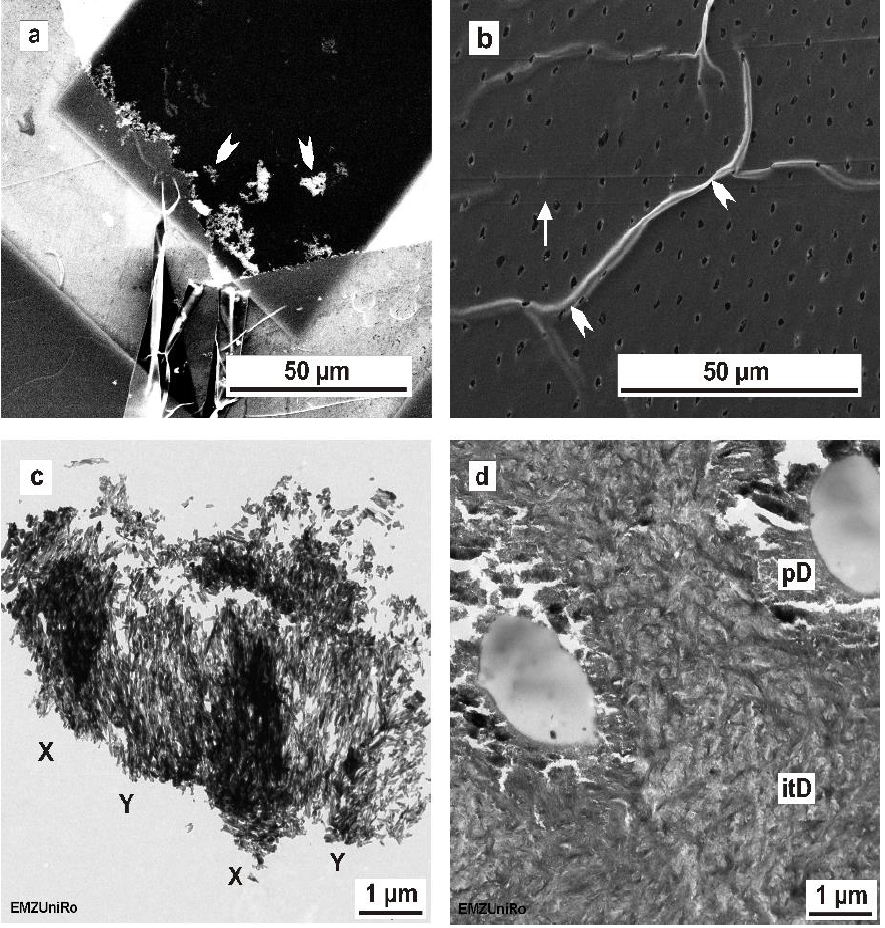
Figure 7. Dentine and enamel ultrathin sections showing ultramicrotome-induced artefacts. ( a ) SEM image of ultramicrotome-prepared enamel. TEM examination is only possible near the enamel – epoxy – resin interface (white arrow heads). Enamel in the center of the ultrathin section became lost during the preparation process using ultramicrotomy. ( b ) SEM image of ultramicrotome-prepared dentine showing local folding (white arrow heads) and cutting marks (white arrow). ( c ) TEM image of ultramicrotome-prepared enamel. The X – Y bending indicates chatter marks. ( d ) TEM image of ultramicrotome-prepared dentine showing local cracks at the peritubular dentine (pD), with intertubular dentine